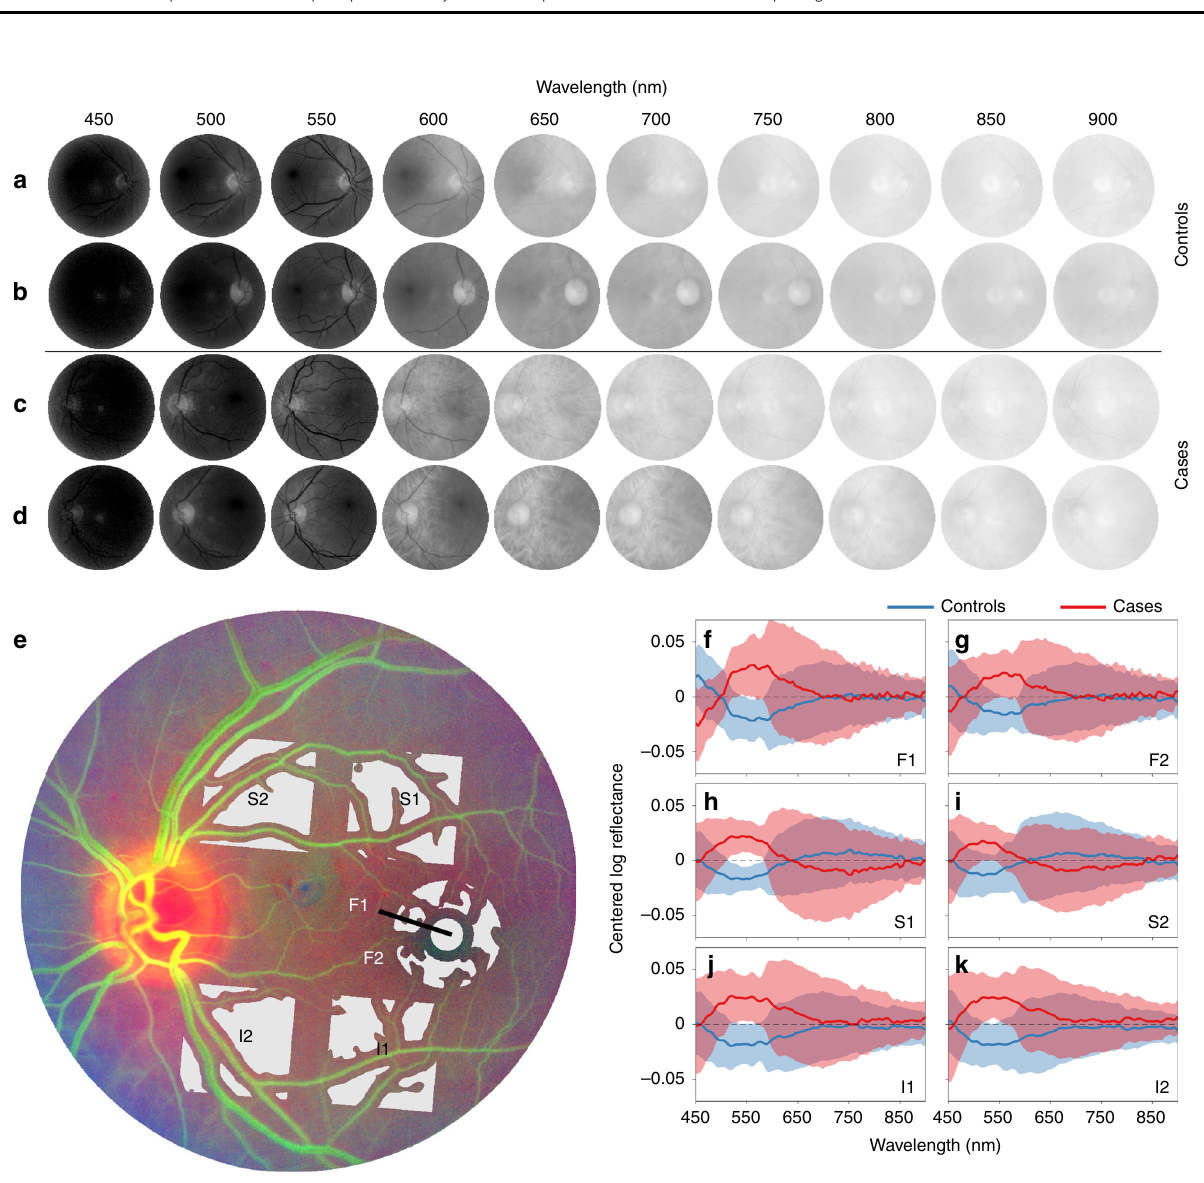
Fig. 2 Spectral variation between eyes precludes discrimination between cases and controls. a – d Representative hyperspectral (HS) montages of four eyes ( n = 2 controls, n = 2 cases from 450 to 900 nm in 50nm steps) showing the inherent variability within- and between eyes owing to the retinal and choroidal vasculature, ocular pigment and ocular media. e Systematic sampling method used to analyse HS images including foveal locations (F1, F2) as well as locations superior (S1, S2) and inferior (I1, I2) to the temporal vascular arcades with segmentation of the major inner-retinal blood vessels. f – k Centred re fl ectance spectra at the different sampling locations for controls ( n = 20, blue) and cases ( n = 15, red) highlighting the large degree of inter-subject variability using uncorrected spectral data, which precludes discrimination between cases and controls. Centred spectra were obtained by subtracting the average spectrum from the spectrum measured for individual participants in the principal cohort (A β PET + and PET − ). Data shown as mean ±